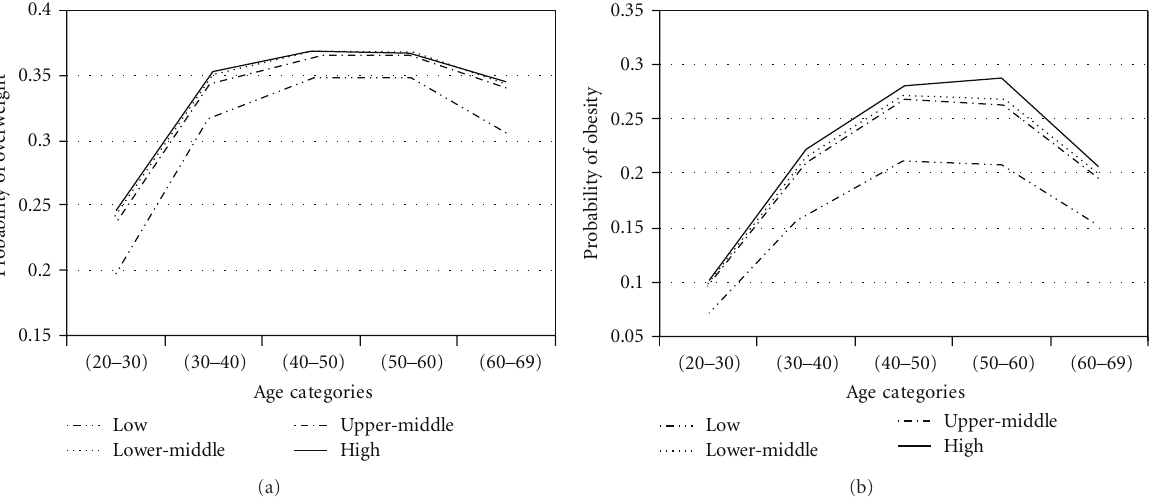
Figure 2: Probabilities of overweight and obesity across age groups for economic